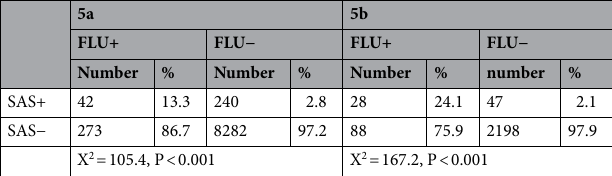
Table 5. Cross tabulation table for FLU and SAS positivity (5a: all age, 5b: 20 s).